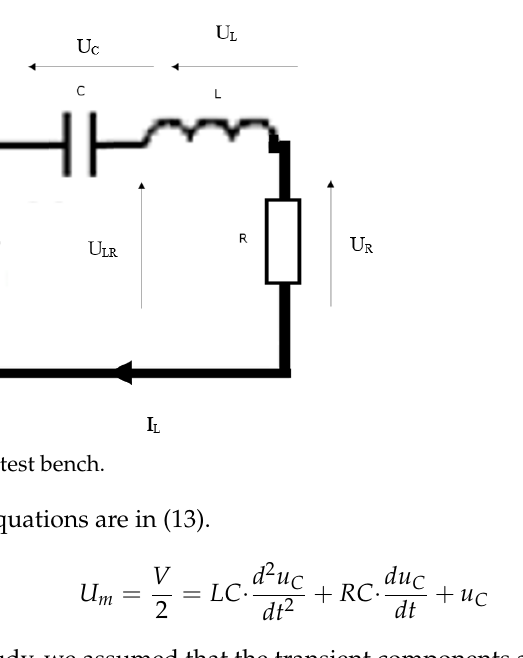
Table 3. Transformer simulation result.